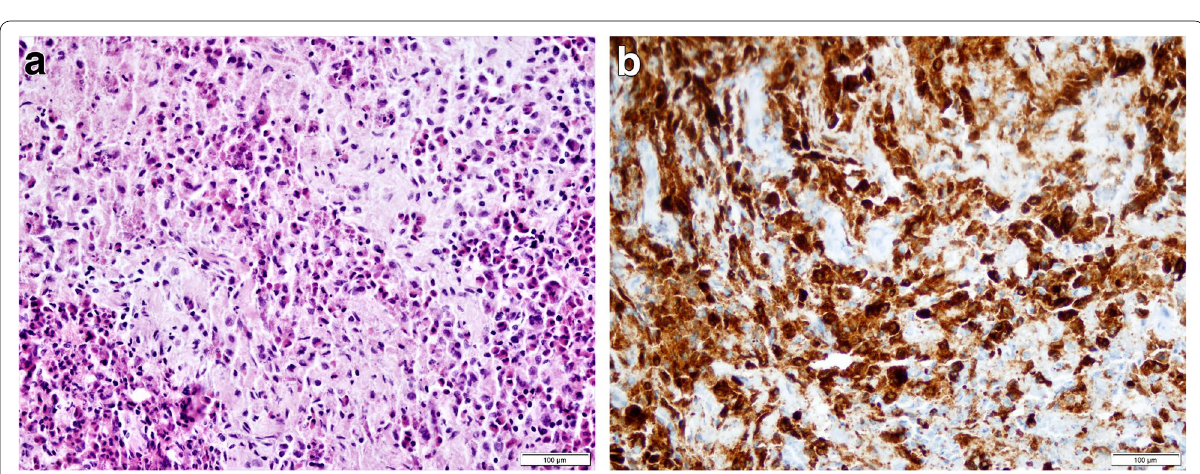
Fig. 3 a Langerhans cells in an eosinophil-rich inflammatory background (H&E; ×